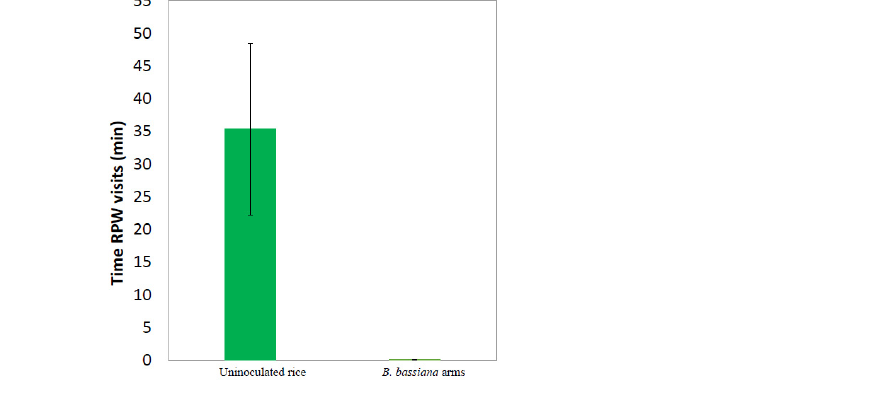
Table 2. Volatile organic compounds (VOCs) detected from Rice ( Oryza sativa ). Peak No.